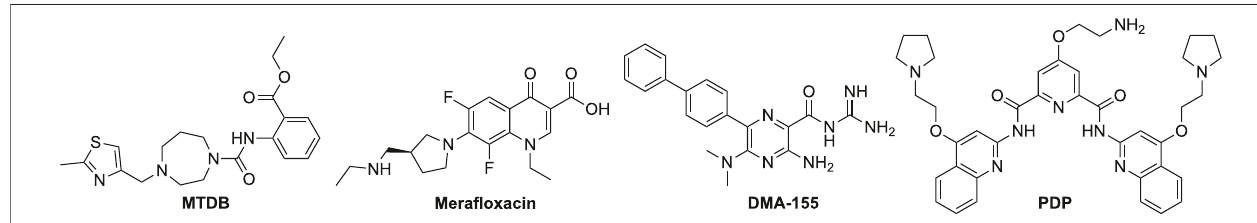
FIGURE 4 | The small molecules with antiviral activities targeting the SARS-CoV-2 RNA genome.